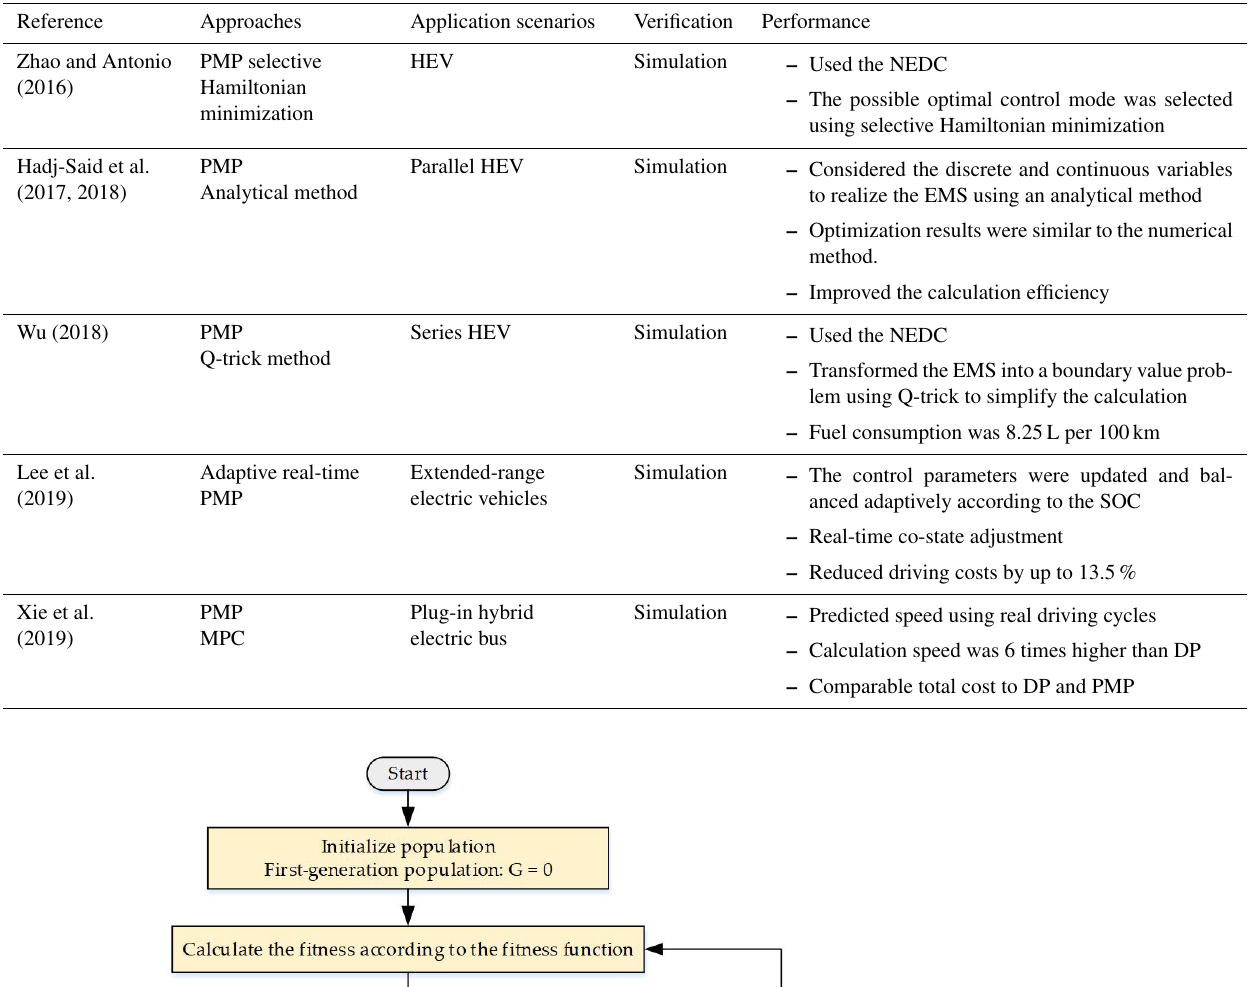
Table 6. Summary of exemplary works on PMP-based EMSs.